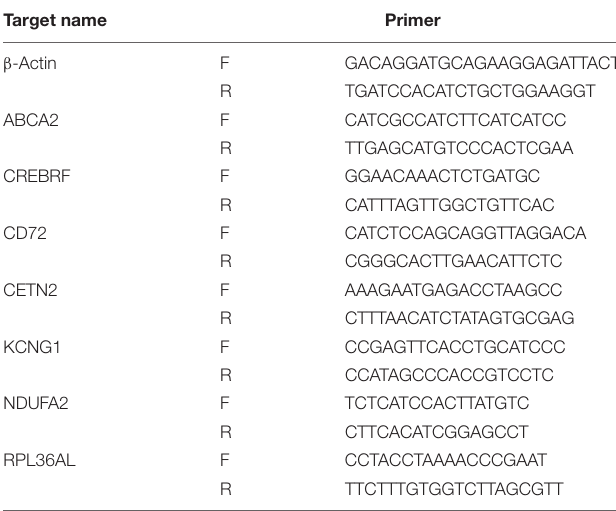
TABLE 1 | Primer information.